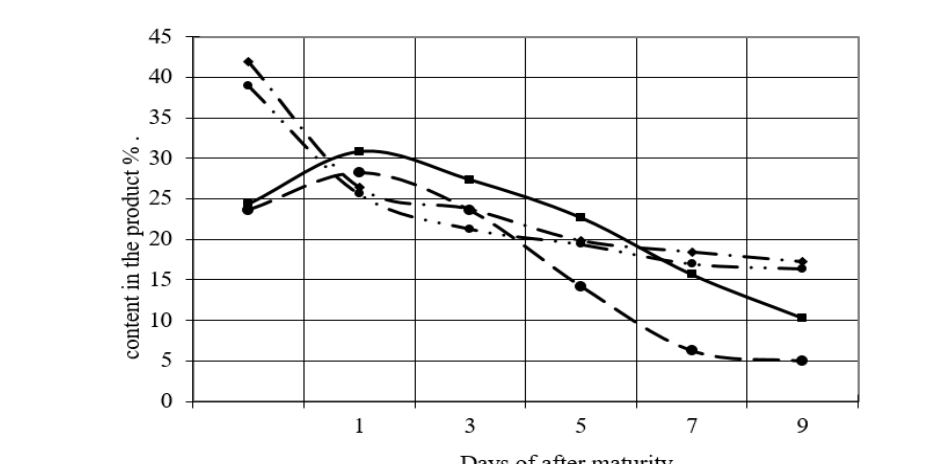
Fig. 1. Comparative evaluation of the process of nectar dehydration of in the honeycomb of strong and weak families, along with the inversion of sucrose: dynamics of water content in the product from the honeycomb of strong families; dynamics of water content in the product from the honeycomb of weak families; dynamics of sucrose inversion in the product from the honeycomb of strong families; dynamics of sucrose inversion in the product from the honeycomb of weak families.